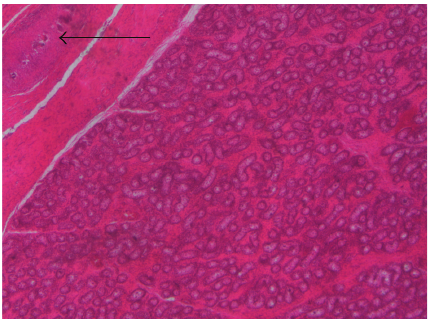
Figure 2: H and E stain showing atrophic testis and granulomatous lesion and schistosoma eggs in tunica (see the arrow) ( × 2).